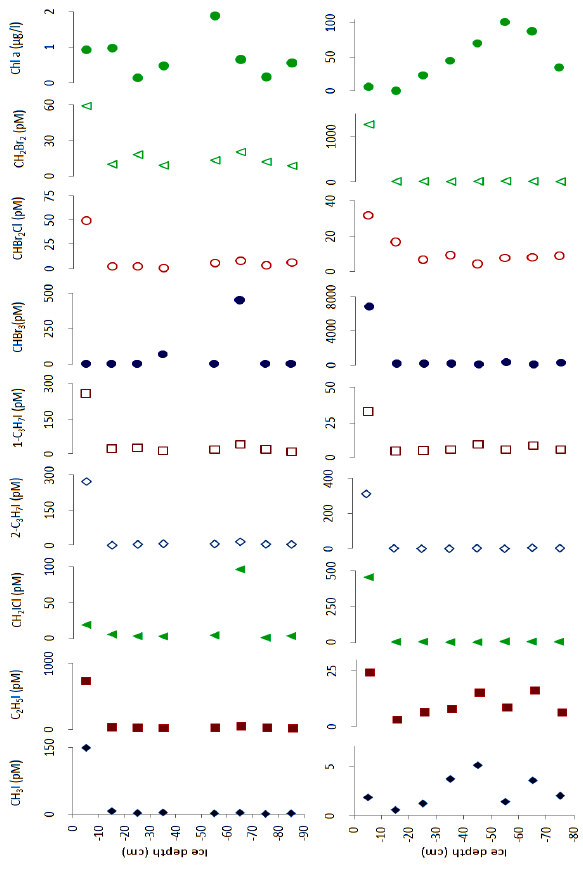
Fig. 7. Vertical profiles of Chl a and halocarbons in sea ice on 5 Feb (left panel) and 13 Feb (right panel). Values have been normalised to brine volume and salinity rationalised as described in text.